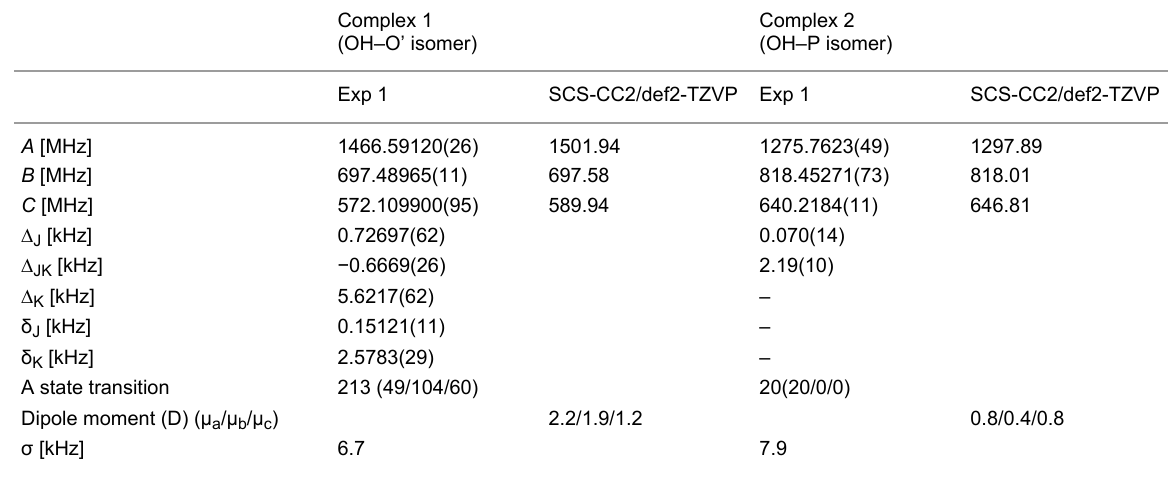
Table 3: Experimental rotational constants of the two observed complexes, using neon as carrier gas, that are assigned to the OH–O’ and the OH–P isomers, respectively. The experimental rotational parameters for the OH–O’ isomer (called Exp 1) are the results of a fit to a rigid-rotor asymmetric Hamiltonian including solely the A lines of the internal rotation splitting. Rotational parameters of a global fit (XIAM) including both A and E levels due to internal rotation for the OH–O’ isomer are presented in the Table S9 of Supporting Information File 1.